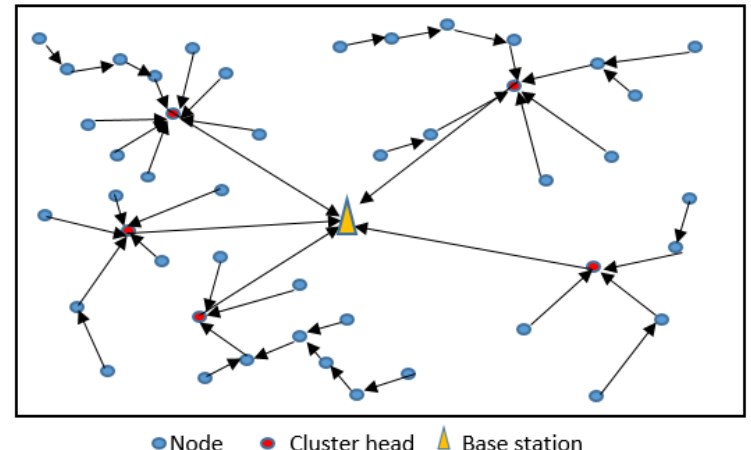
Figure 1. Network